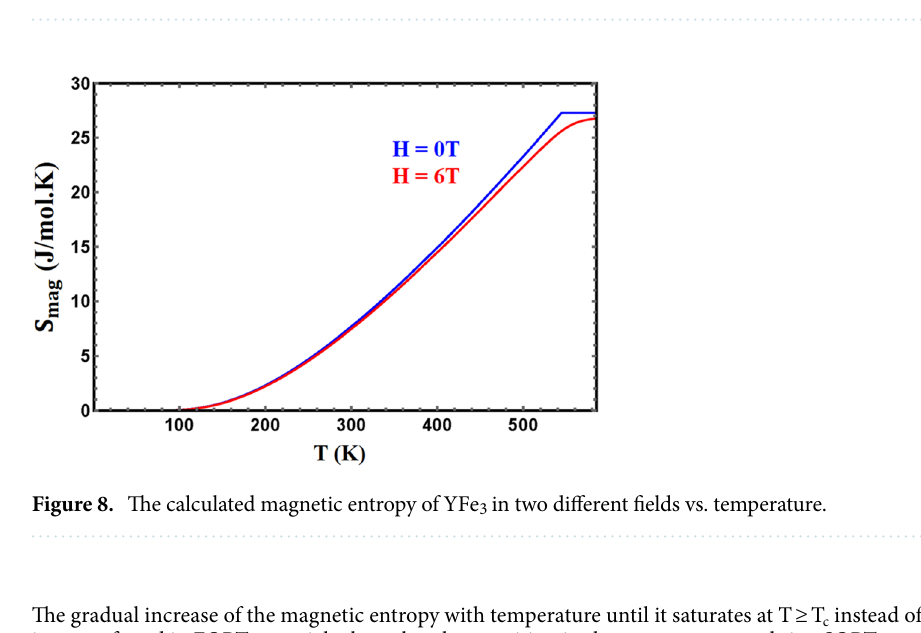
Figure 7. Magnetic heat capacity of HoFe 3 in different fields, vs. temperature.